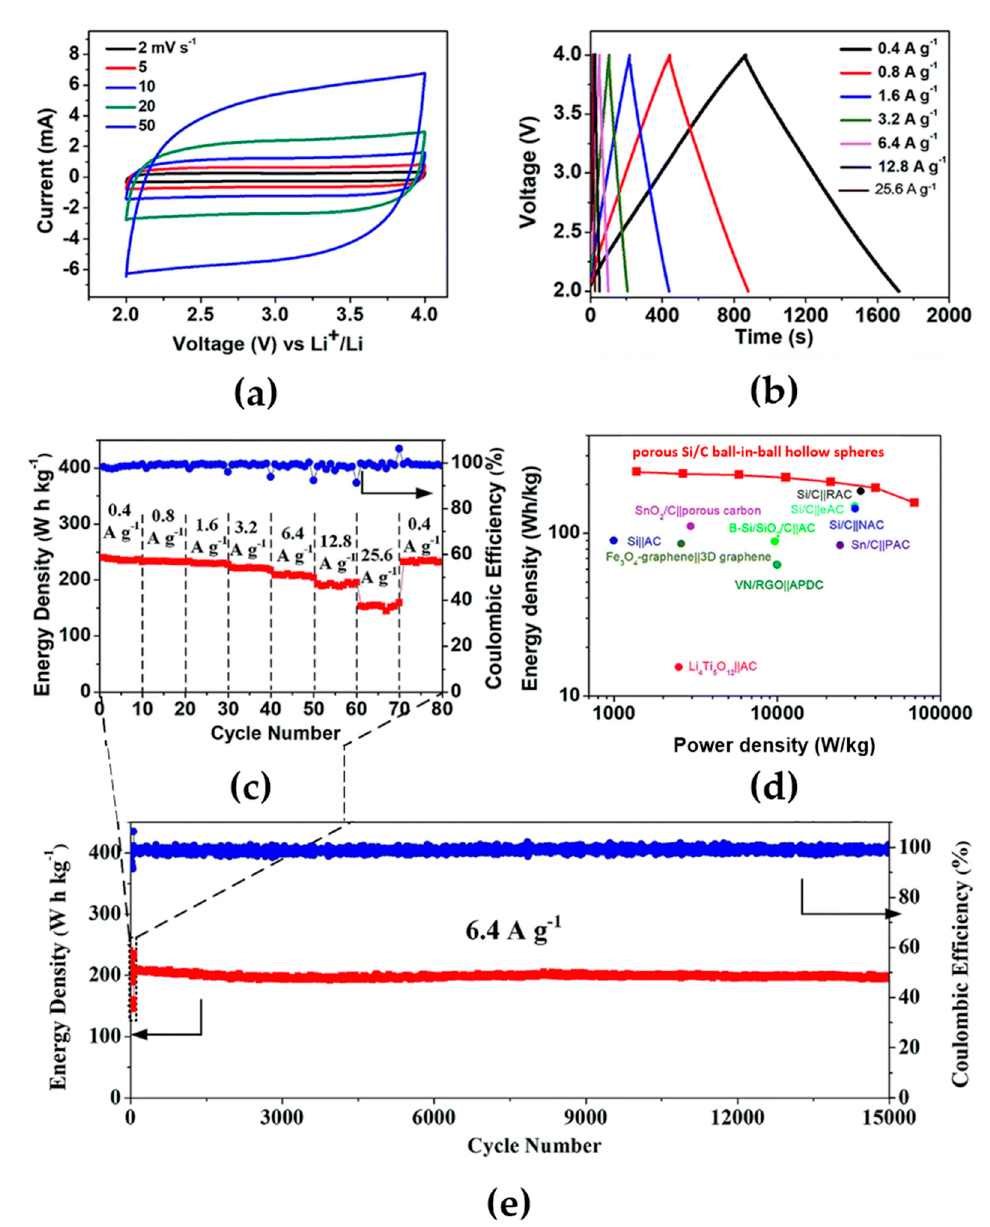
Figure 5. Performance of porous Si/C ball-in-ball HSs: ( a ) CV curves at different scan rates; ( b ) voltage profile; ( c ) rate performance; ( d ) Ragone plot, and ( e ) long cycling performance at 6.4 A g − 1 of a Si@C ball-in-ball HSs ‖ RAC LIC full cell. Adapted from [89] .